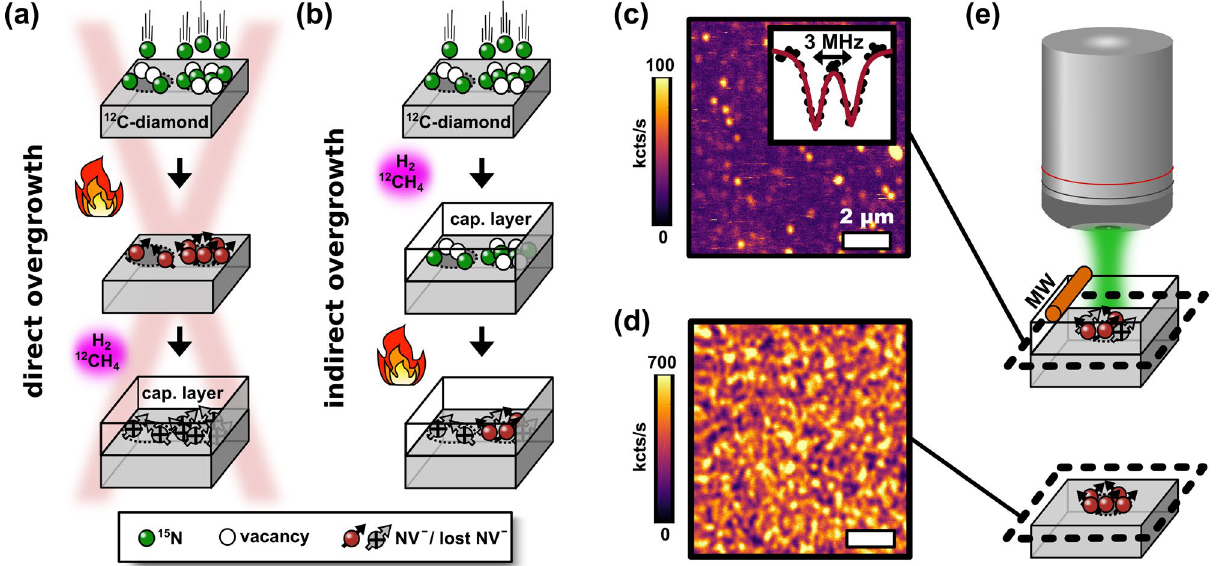
Figure 1. Combining ion implantation of 15 N + and chemical vapor deposition (CVD) for the depth- controlled fabrication of NV − centers. ( a ) Direct overgrowth: 15 N + nitrogen ion implantation into 99.999% 12 C enriched diamond, ultra high vacuum (UHV) annealing at 1000 ◦ C yielding NV − centers, and overgrowth of a nanometer-thick capping layer. The implantation spots are not visible anymore after the direct overgrowth of NV − centers. ( b ) Indirect overgrowth: analogous to ( a ) but overgrowing prior to annealing. The overgrowth of nitrogen and annealing at the end yields buried NV − centers for medium and high implantation doses ( 10 11 and 10 12 15 N + / cm 2 ), whereas for the lowest dose ( 10 9 15 N + / cm 2 ) the implantation spots still vanish. ( c ) Confocal image showing the fluorescence of implanted single NV − centers (medium dose) after the indirect overgrowth with a capping layer of 13 nm thickness. Inset: a representative pulsed optically-detected-magnetic resonance measurement with two dips corresponding to the 15 N -nuclear hyperfine interaction with the electron spin of the NV − center. ( d ) Reference image for ( c ) without overgrowth. ( e ) Scheme of the confocal measurements performed in ( b ) and ( c ) employing a 519 nm laser and coherent microwave control (MW) through a copper wire.